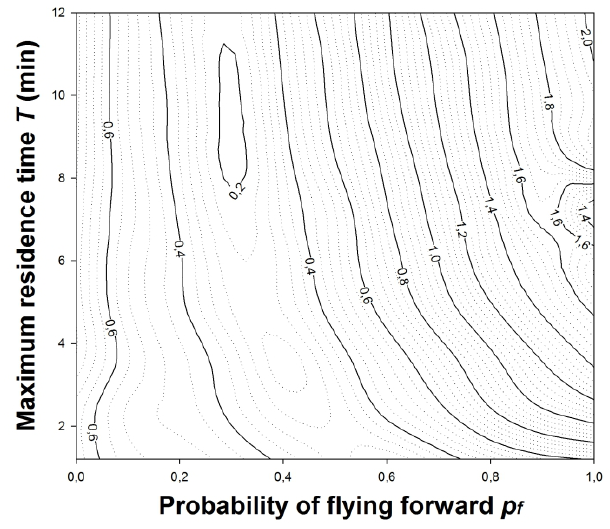
Fig. 3. Relative deviation s _distclass between model output and empirical data as a function of the model parameters pf and T (for details see